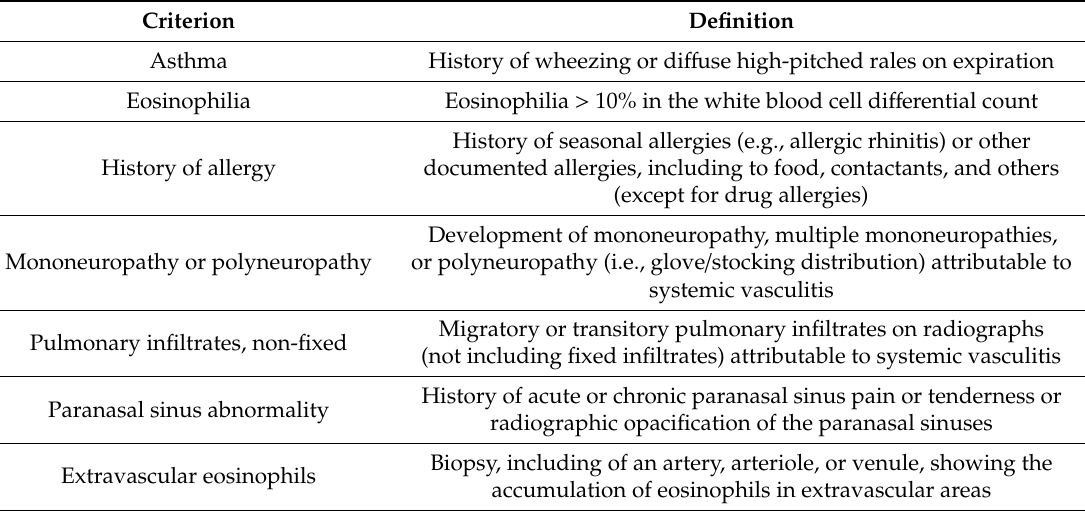
Table 1. Criteria and definitions used for the classification of eosinophilic granulomatosis